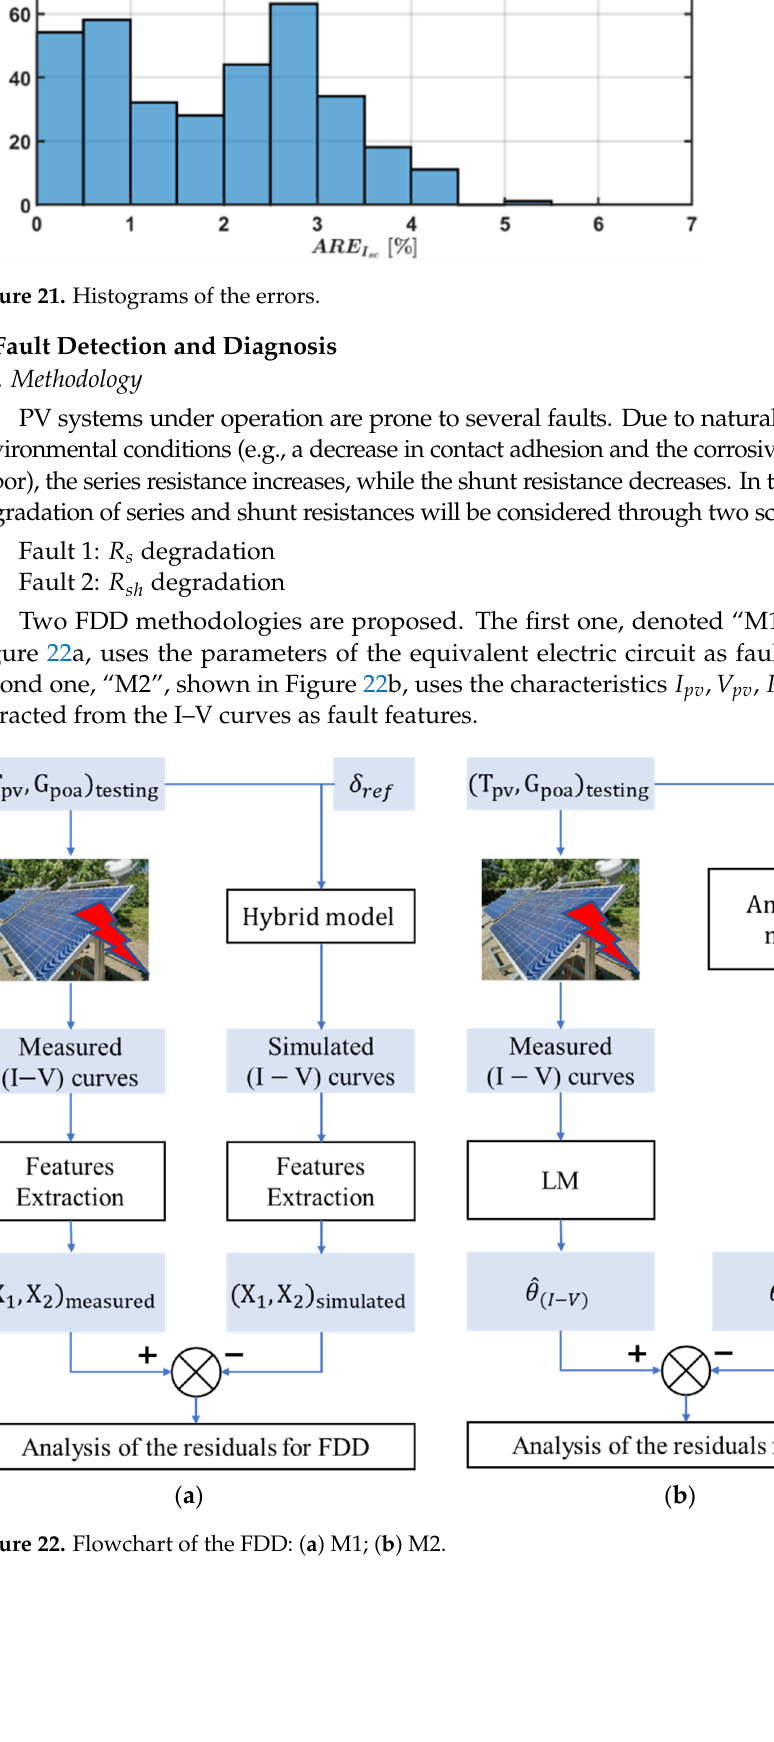
Figure 22. Flowchart of the FDD: ( a ) M1; ( b ) M2 .